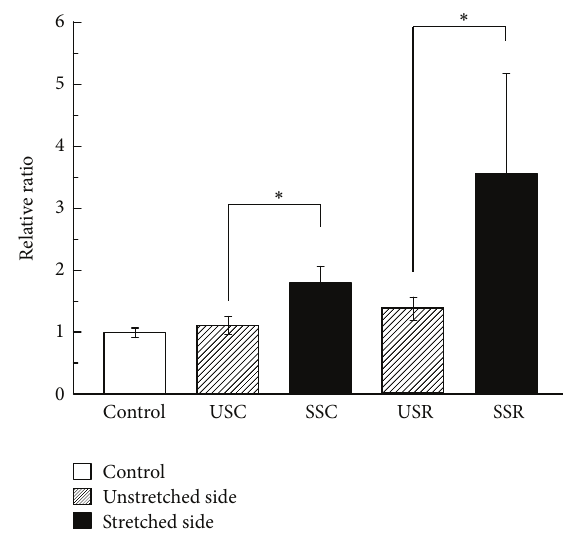
Figure 1: MyoD mRNA expression. Relative ratio of MyoD mRNA expression induced under different stretching conditions (mean ± SE). The open bar shows the control group; shaded bars denote the unstretched side of continuous stretching and repetitive stretching; andfilledbarsdenotethestretchedsideofcontinuousstretchingand repetitive stretching. Significant differences were displayed ( ∗ 𝑃 < 0.05